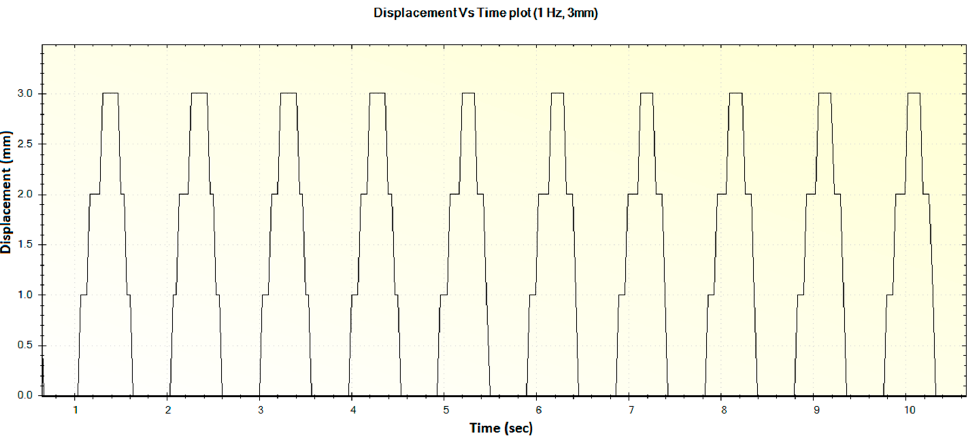
Figure 16. Generated waveform for 1 Hz operation producing a displacement of 3 mm.